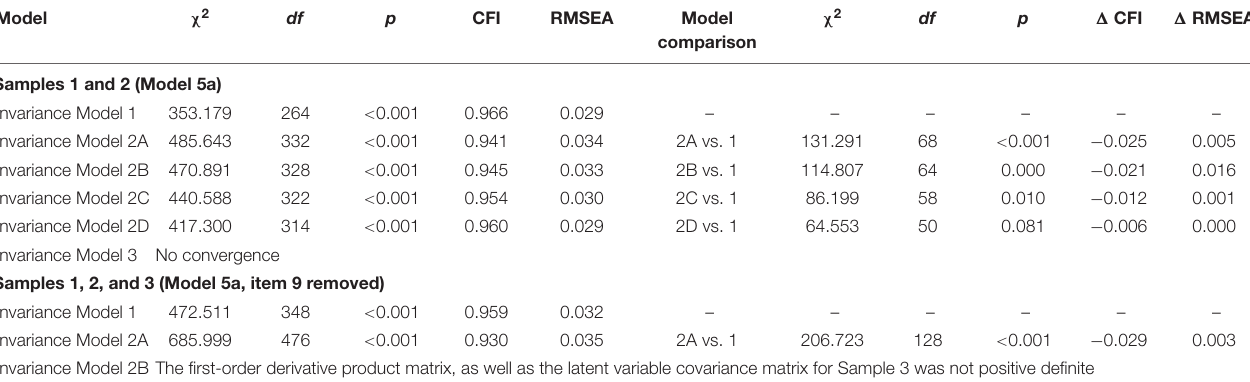
TABLE 4 | Measurement invariance of the QEWB for Samples 1, 2, and 3.